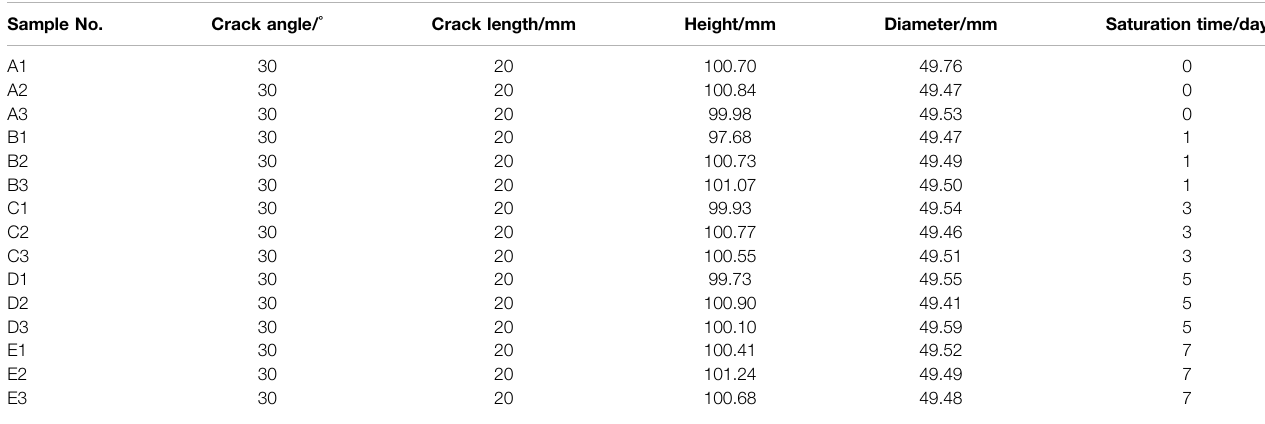
TABLE 1 | Basic parameters of jointed limestone samples. Sample